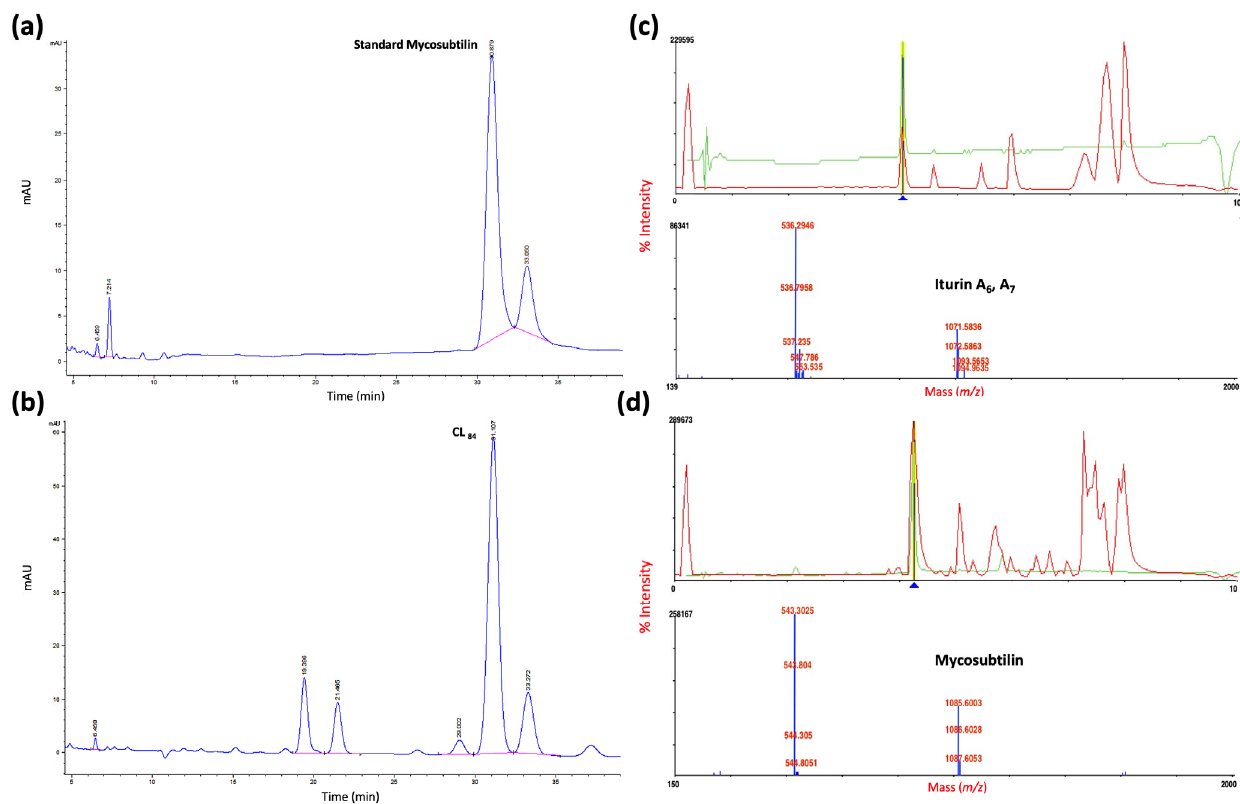
Figure 4. Characterization of lipopeptide for ( a ) HPLC standard mycosubtilin, ( b ) 84 h purified lipopeptide analysis (PL 84 ); MALDI–TOF-MS analysis of ( c ) iturin A 6, A 7 and ( d ) mycosubtilin.